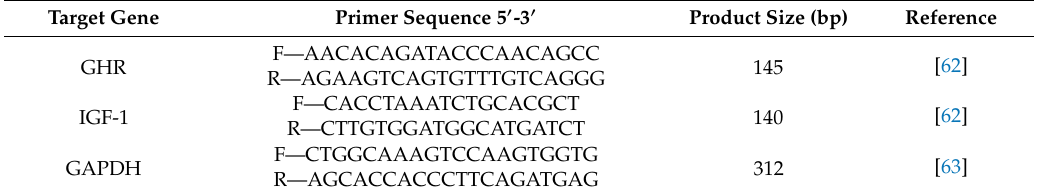
Table 3. The primer sequences of GHR, IGF-1, and GAPDH genes used for RT-qPCR. Target